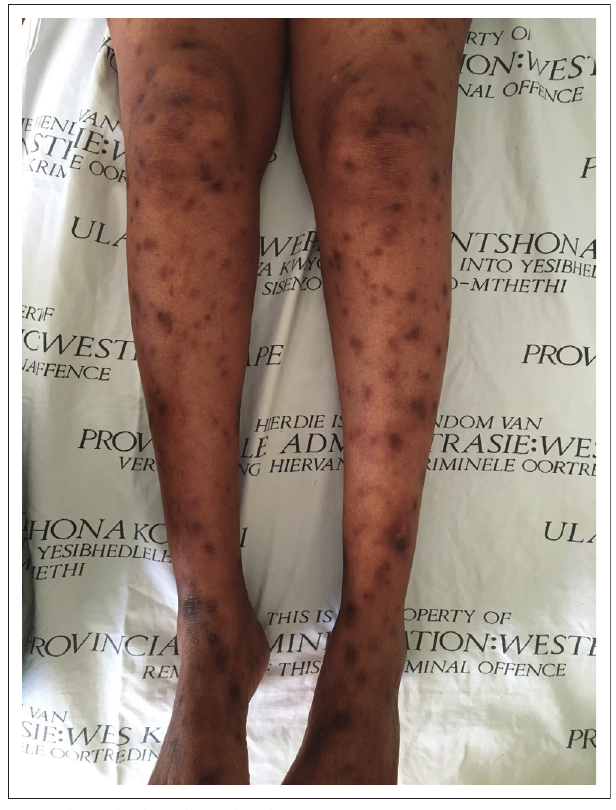
FIG URE 2: Pruritic papular eruption with post-inflammatory hyperpigmentation.